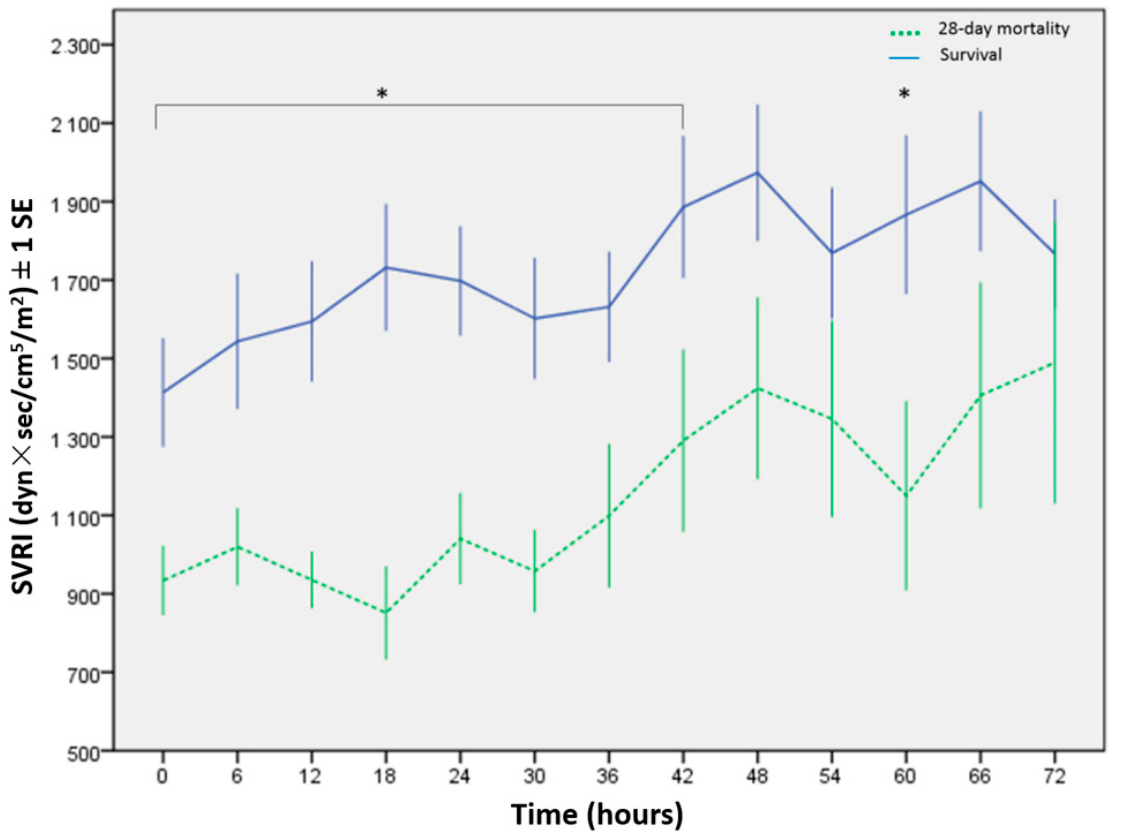
Figure 3. Serial systemic vascular resistance index (SVRI), measured at 6 h intervals. * Statistical significance was set at p < 0.05.